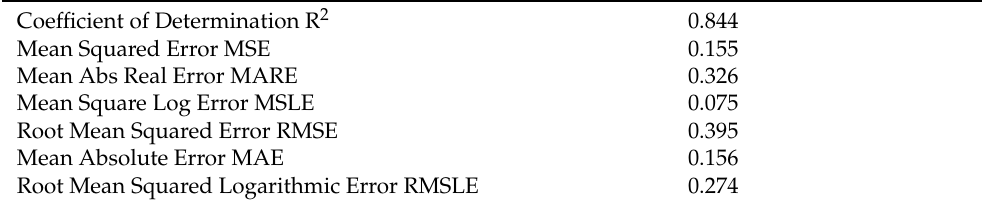
Table 4. MLP model classification errors.